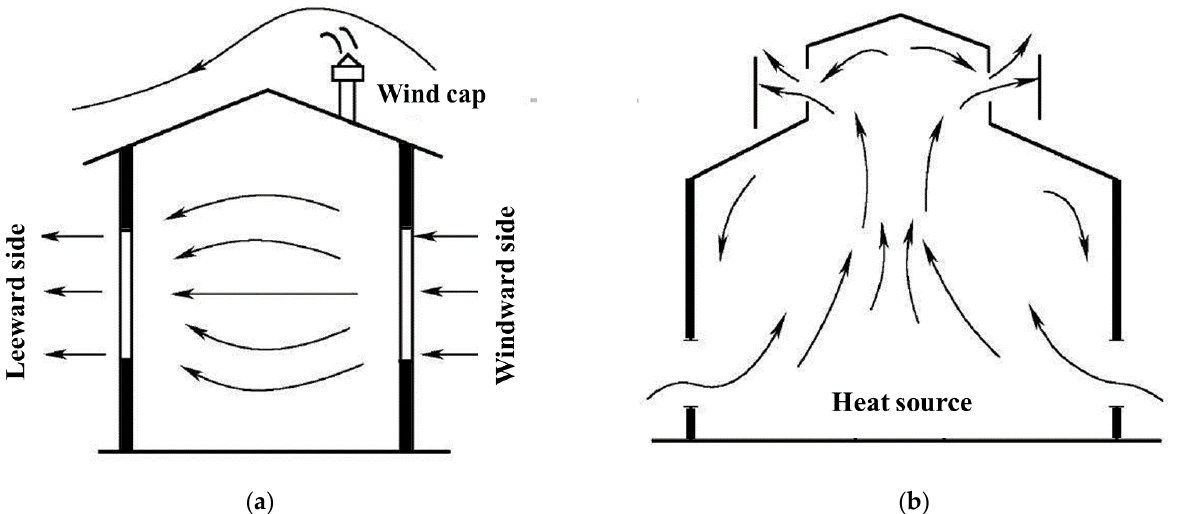
Figure 6. The two principles of natural ventilation. ( a ) Wind pressure ventilation; ( b ) hot pressure ventilation.